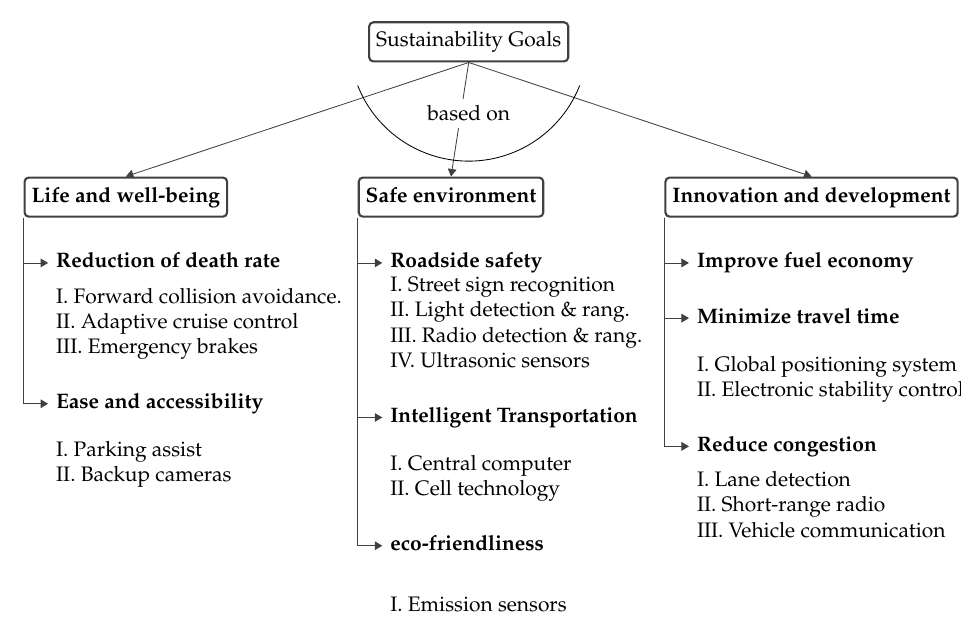
Figure 2. Sensor-to-Sustainability: first taxonomy that maps EV sensors with domains of sustainability. The predicate logic representation of the taxonomy has been presented in Equation